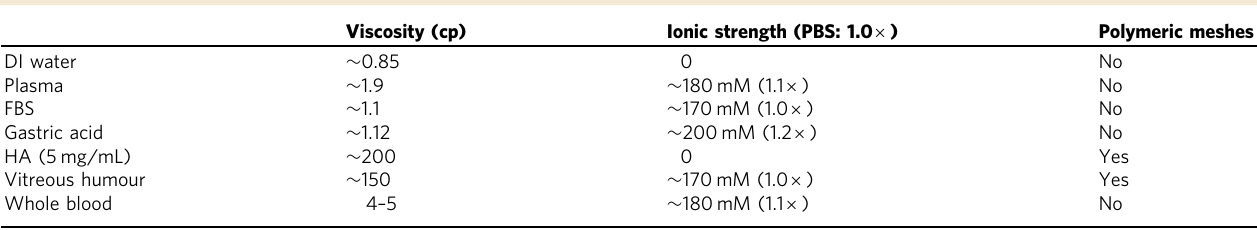
The viscosities are obtained at the shear rate of 10s (cid:3)